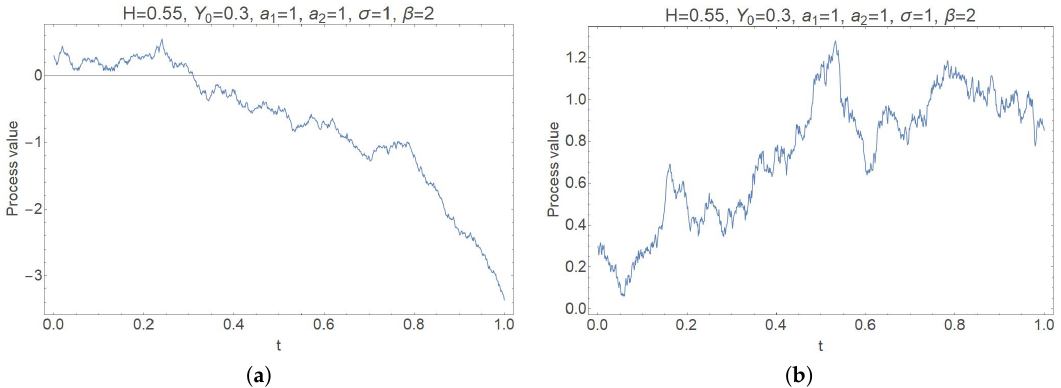
Figure 1. Trajectory of Y : ( a ) with negative values. ( b ) with positive values.